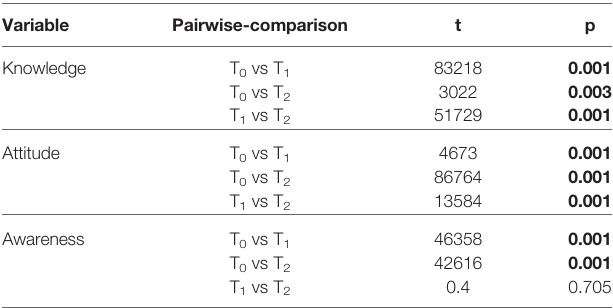
TABLE 4 | Pairwise comparison a among times (T 0 : before GE activities; T 1 : short term after GE activities; T 2 : long term after GE activities) for all sustainability variables (knowledge, attitude,